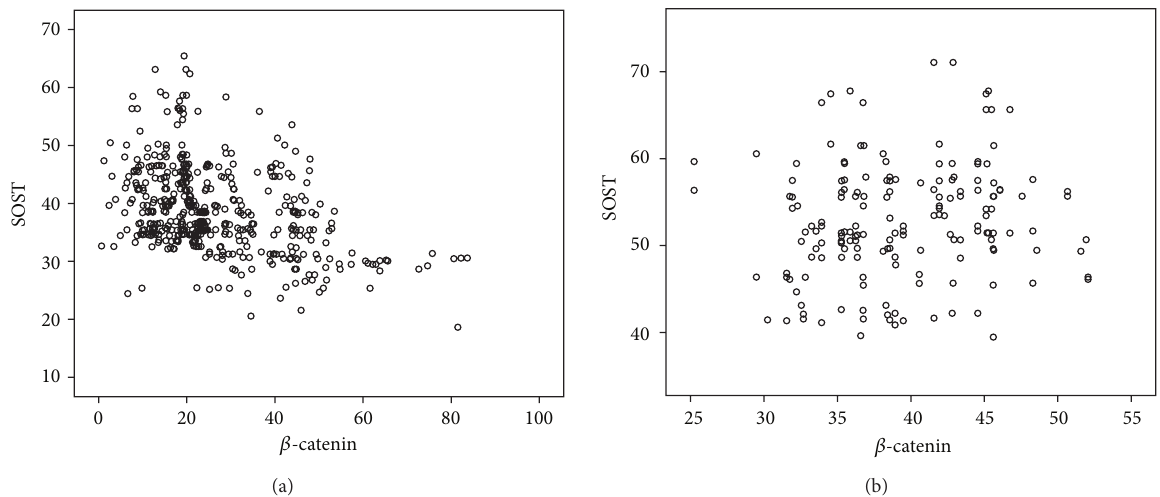
Medicine of Union Hospital in Wuhan for providing auto- mated electrochemiluminescence system and Lunar